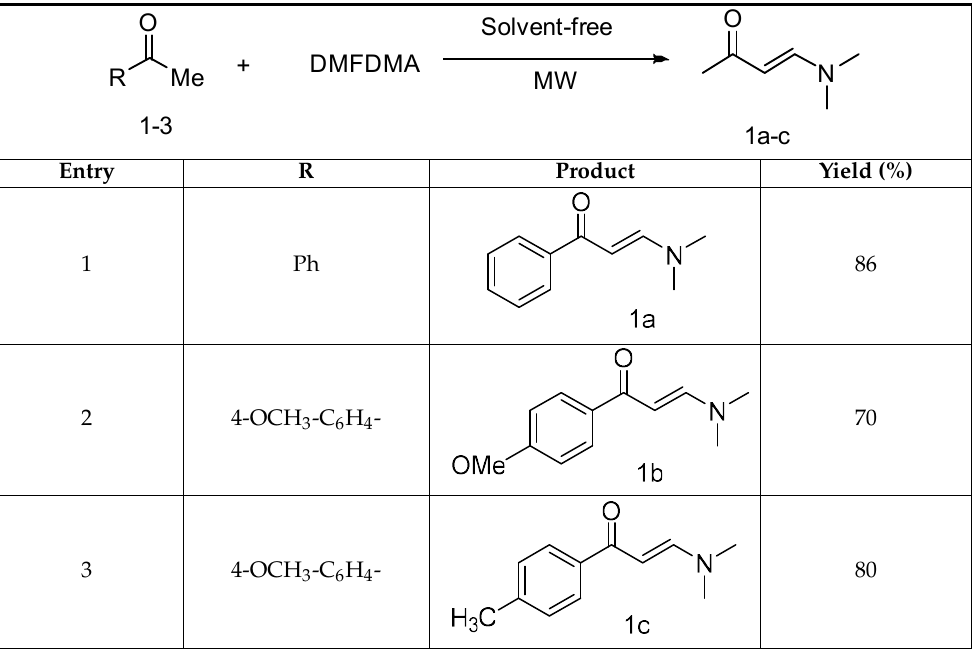
Table 1. Synthesis of Enaminone 1a–c.